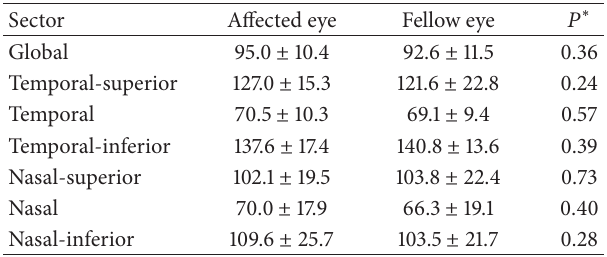
Table 2: Comparison of circumpapillary global and sectoral RNFL thickness ( 𝜇 m) in affected and fellow eyes ( 𝑛 = 36